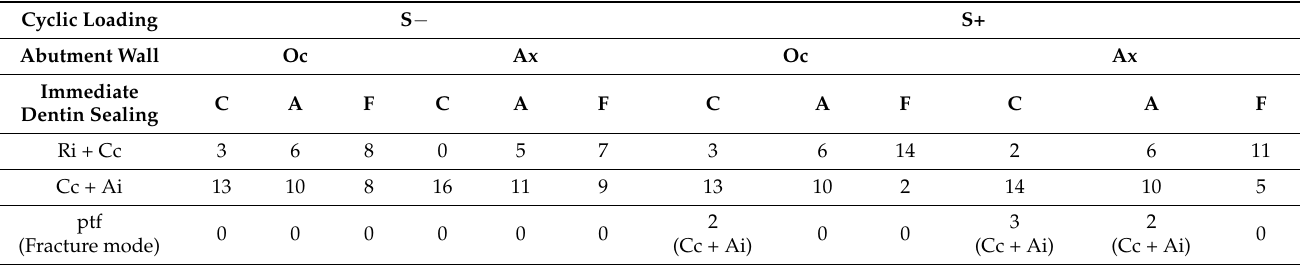
Table 4. Distribution of fracture mode.